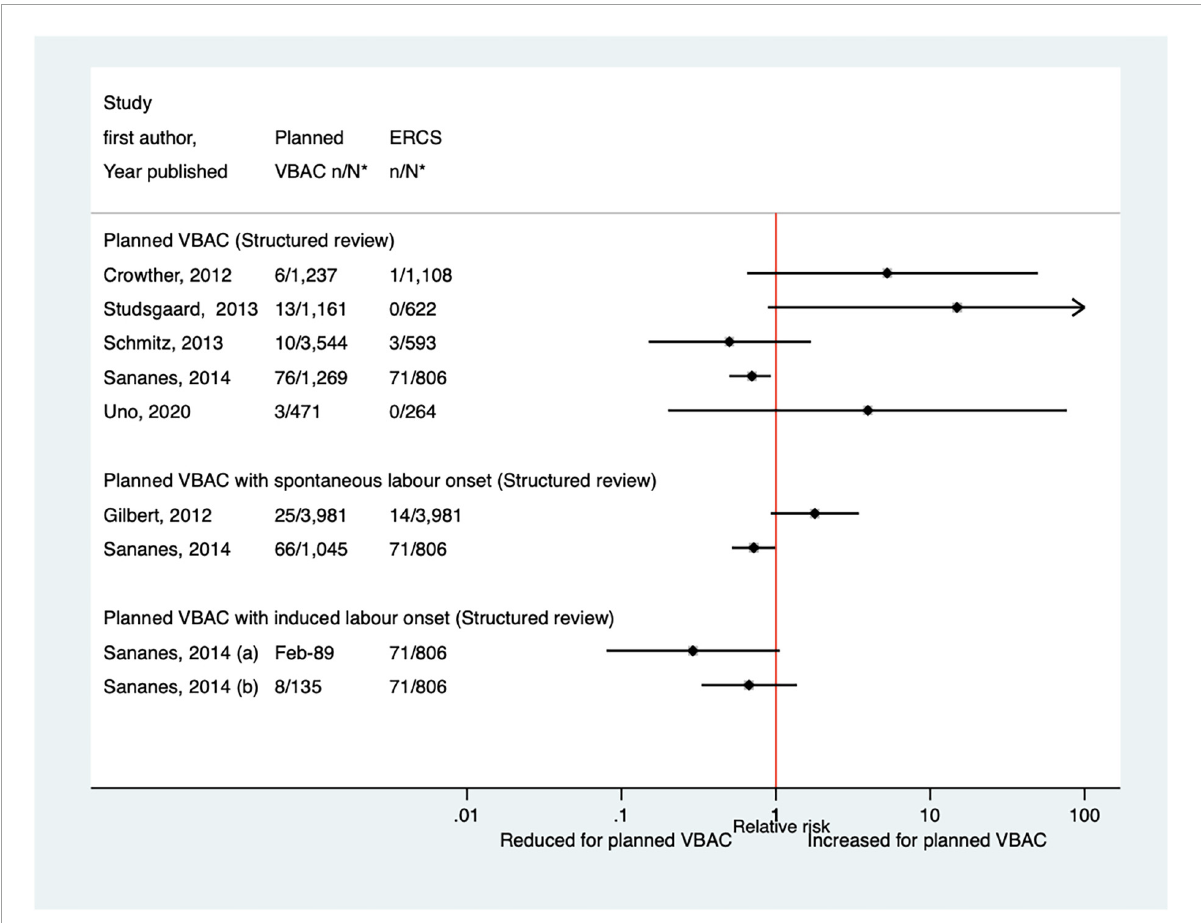
FIGURE11 Risk of cord pH < 7 for planned VBAC vs. ERCS. * n , number in group with the outcome; N , Total number in group. Sananes et al. (49) (a) planned VBAC with induction of labor with oxytocin and amniotomy, (b) planned VBAC with induction of labor with foley catheter. ERCS, elective repeat cesarean section; VBAC, vaginal birth after previous